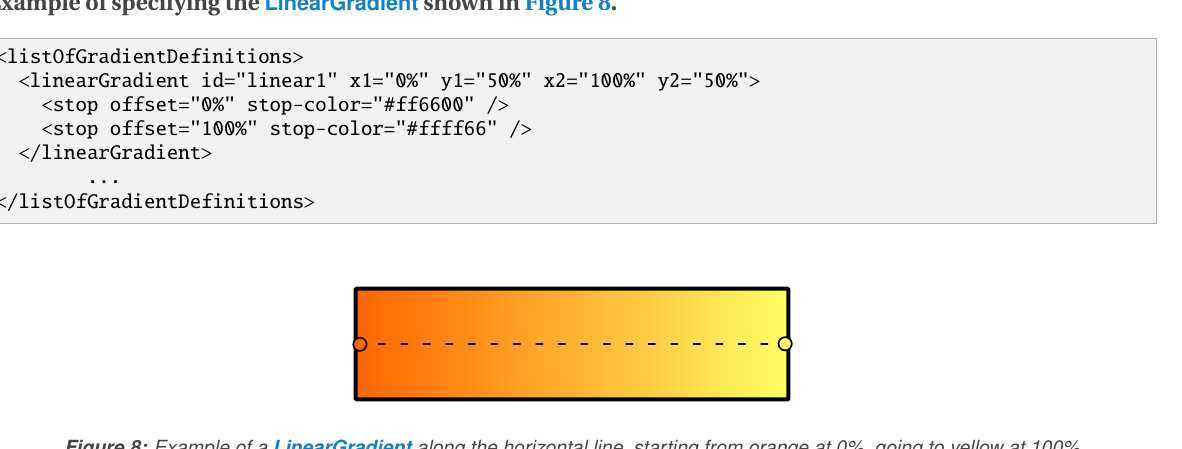
Figure 8: Example of a LinearGradient along the horizontal line, starting from orange at 0%, going to yellow at 100%